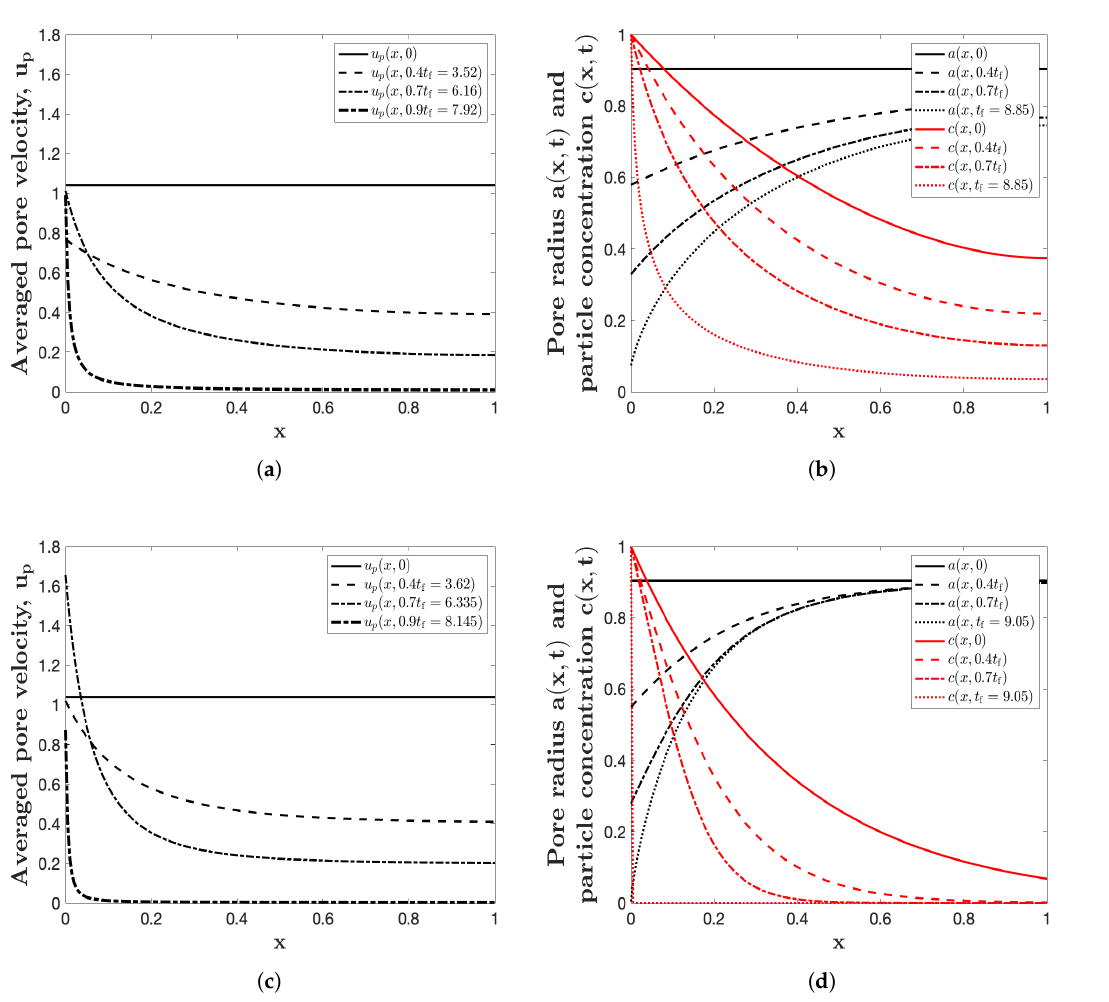
Figure 3. ( a ) The cross-sectionally averaged pore velocity u p with Pe = 2. ( b ) the pore radius a ( x , t ) and particle concentration c ( x , t ) at several different times up to the final blocking time ( t f , indicated in the legends) with Pe = 2. ( c , d ) are as ( a , b ) respectively, with Pe → ∞ . All four simulations are for a uniform initial pore profile a ( x ,0 ) = 0.9, with λ = 2, β = 0.1 and ρ b =